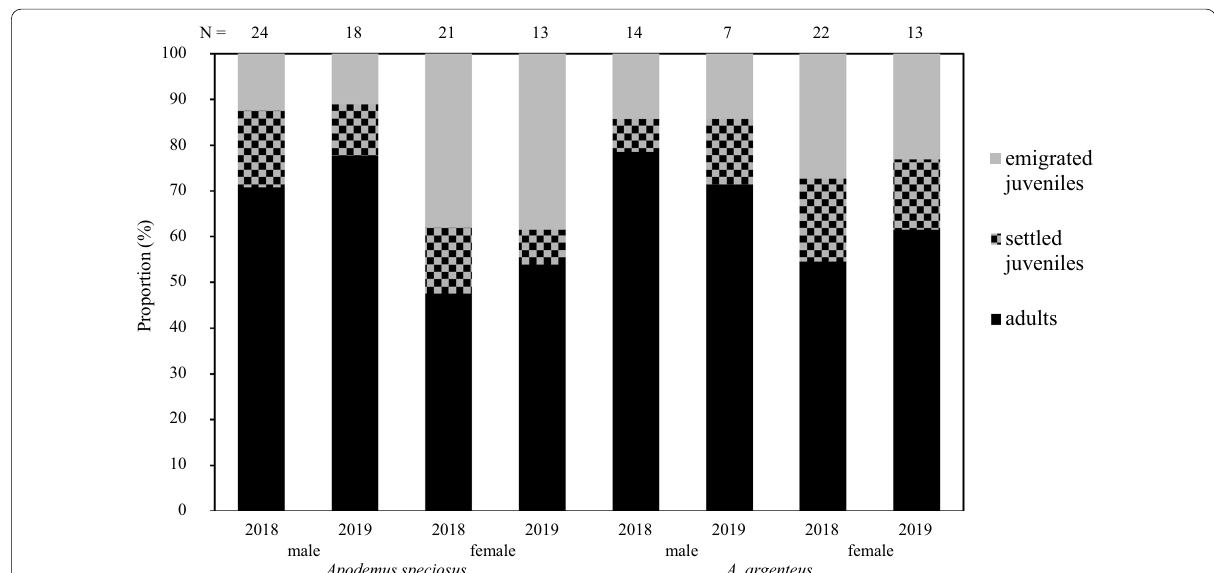
Fig. 4 Proportion of different growing stages of the two Apodemus species individuals captured across the four plots from June to November in both 2018 and 2019. The numbers on the top are sample size ( n ). (Fisher’s exact test: between years and sexes for both A. speciosus and A. argenteus ; p > 0.05, between sexes in A. speciosus ; p < 0.05, between sexes in A. argenteus ; p >